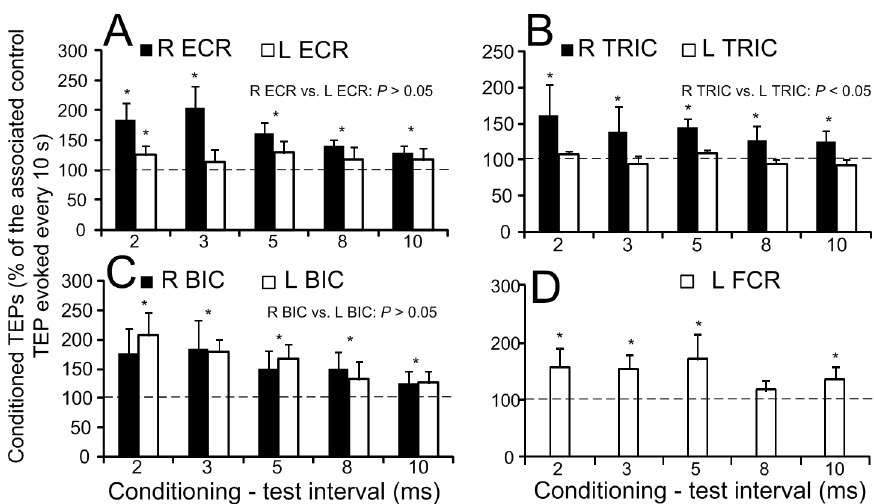
Figure 6. Effects of median nerve stimulation on the amplitude of transpinal evoked potentials (TEPs). Overall mean amplitude of the TEPs recorded bilaterally from the right (R) and left (L) extensor carpi radialis (ECR), triceps brachii (TRIC), biceps brachii (BIC), and left flexor carpi radialis (FCR) muscles following median nerve stimulation at low intensities (Ia afferent). On the abscissa the conditioning-test intervals (ms) tested are indicated. Asterisks indicate statistically significant differences of conditioned TEPs from control values. Error bars indicate the SEM.